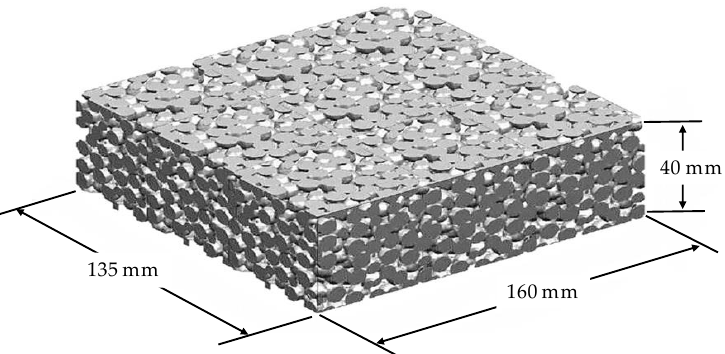
Figure 3. Test specimen size of the porous concrete.